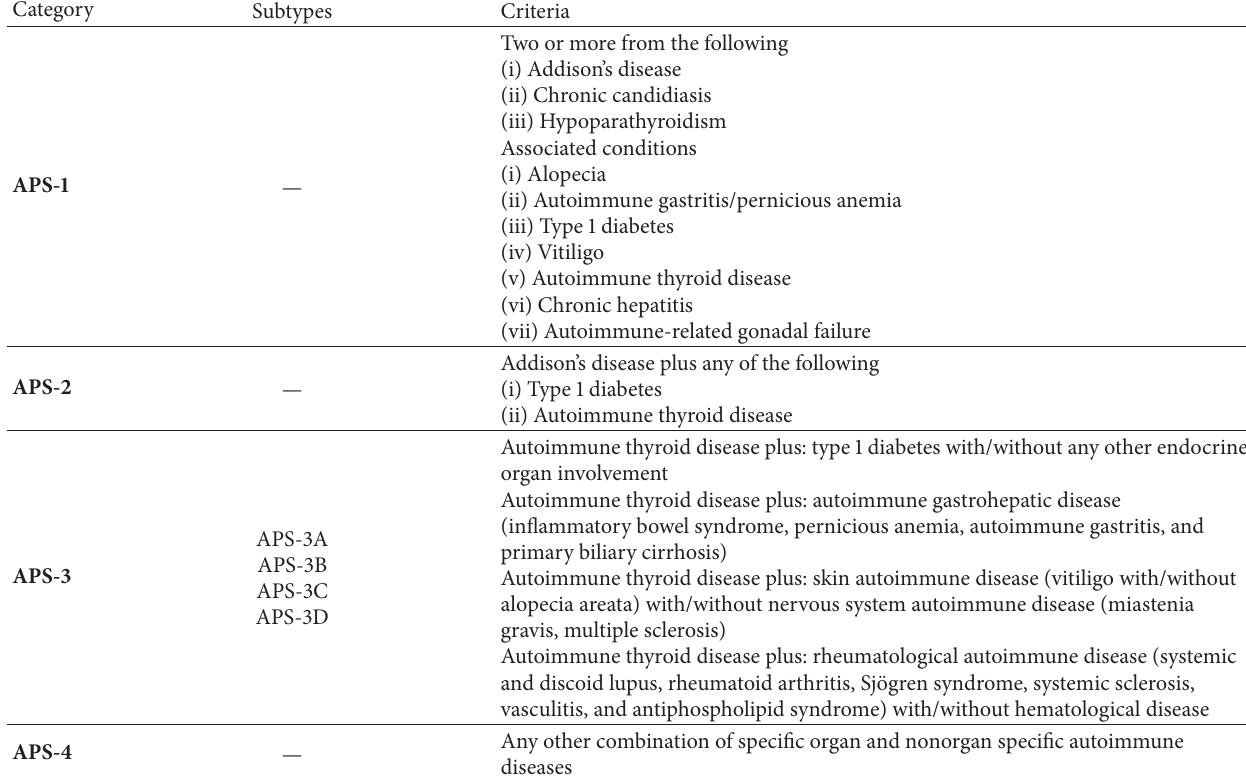
Table 2: Classification of autoimmune polyglandular syndromes